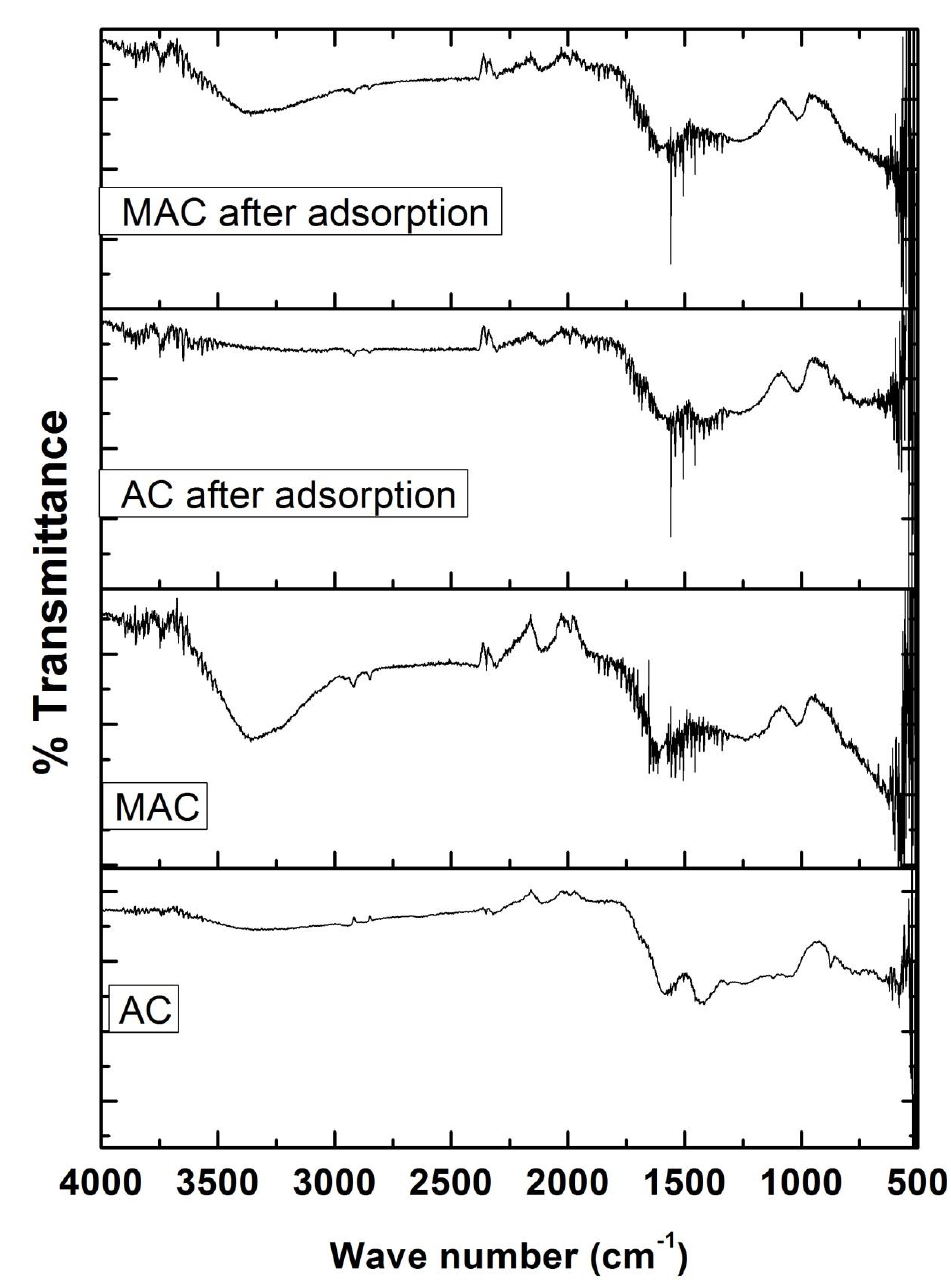
Figure 5. FTIR spectra of AC and MAC before adsorption and after adsorption. The XRD spectrum of AC (Figure 6) indicates the adsorbent to be amorphous, whereas, according to XRD spectrum of MAC (Figure 6), it is crystalline in nature. Several peaks were observed such as 2 θ: 29 (index: 220), 36 (index: 311), 38 (index: 400), and 48 (index: 422) that suggest the presence of magnetite in the composite. Out of the numerous iron oxides present, maghemite and magnetite were deemed to be of special value because